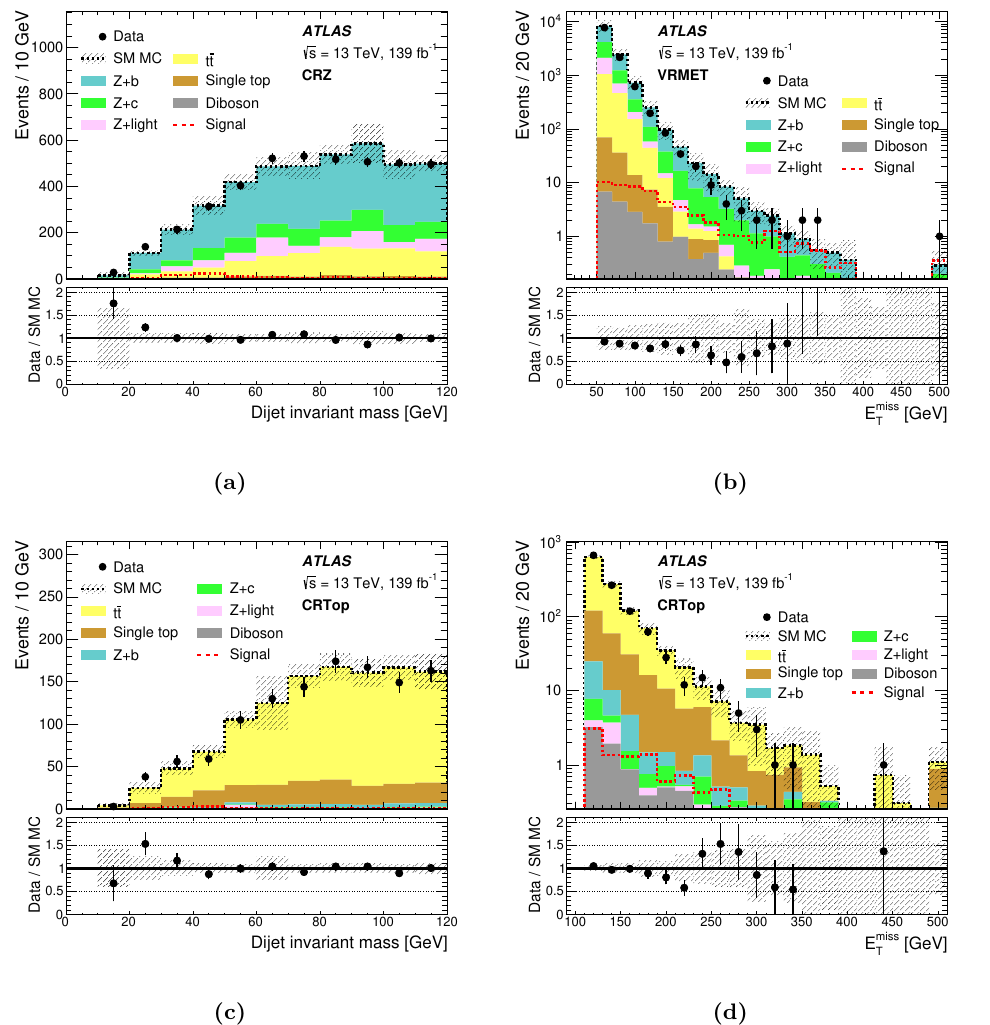
(c) Figure 1. Comparison of data and simulation for (a) the dijet invariant mass in CRZ, (b) E miss T in VRMET, (c) the dijet invariant mass in CRTop and (d) E miss in CRTop. The Z+HF and tt T scale factors, described in the text, have been applied to the simulated samples. The lower panels show the ratio of data to SM MC simulation. The total statistical and systematic uncertainties are denoted by the hatched band. Large fluctuations in single bins of the systematic uncertainty band can be caused by high-weight events in the systematic variation samples. The overlaid distribution labelled ‘Signal’ is for the model with ( m , m , m ) = (45 GeV, 10 GeV, 80 GeV), setting all a ˜ χ 0 1 ˜ χ 0 2 0 ¯ ˜ χ 0 ˜ χ 0 ˜ χ 0 ˜ χ 0 branching ratios to 100% in the decay chain H → ˜ χ 0 b ˜ χ 2 1 → a 1 1 → b 1 1